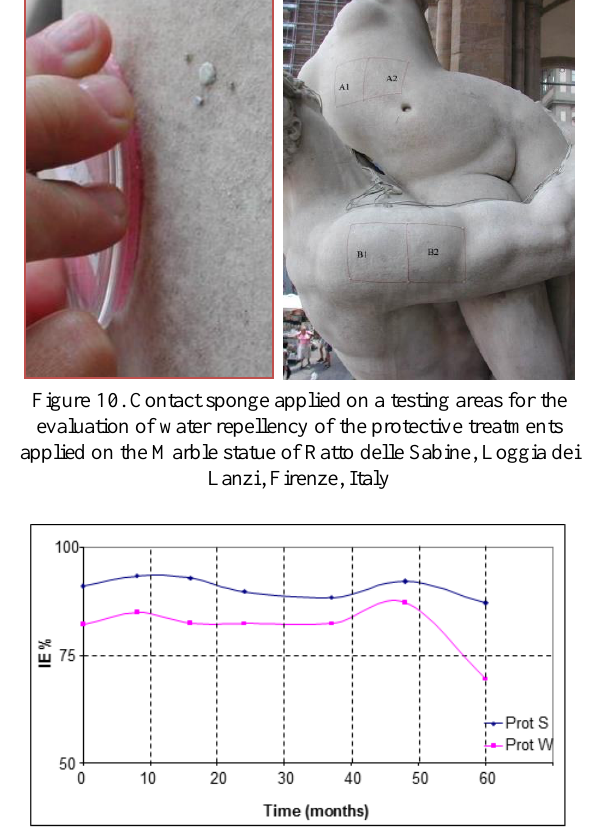
Figure 11. Water repellency monitoring, by the Contact Sponge, of the two protective treatments applied on the marble statue of Ratto delle Sabine